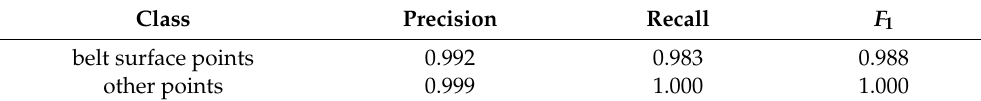
Table 2. Classification evaluation metrics.